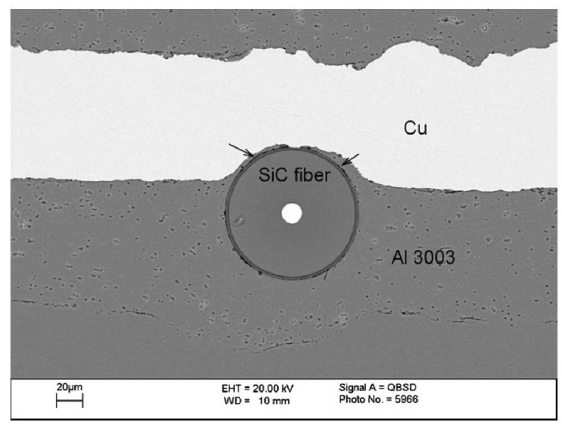
Figure 12. SiC fiber embedded between Al 3003/Cu foils. Note the aluminum flow around the fiber into the Cu side (shown by arrows)